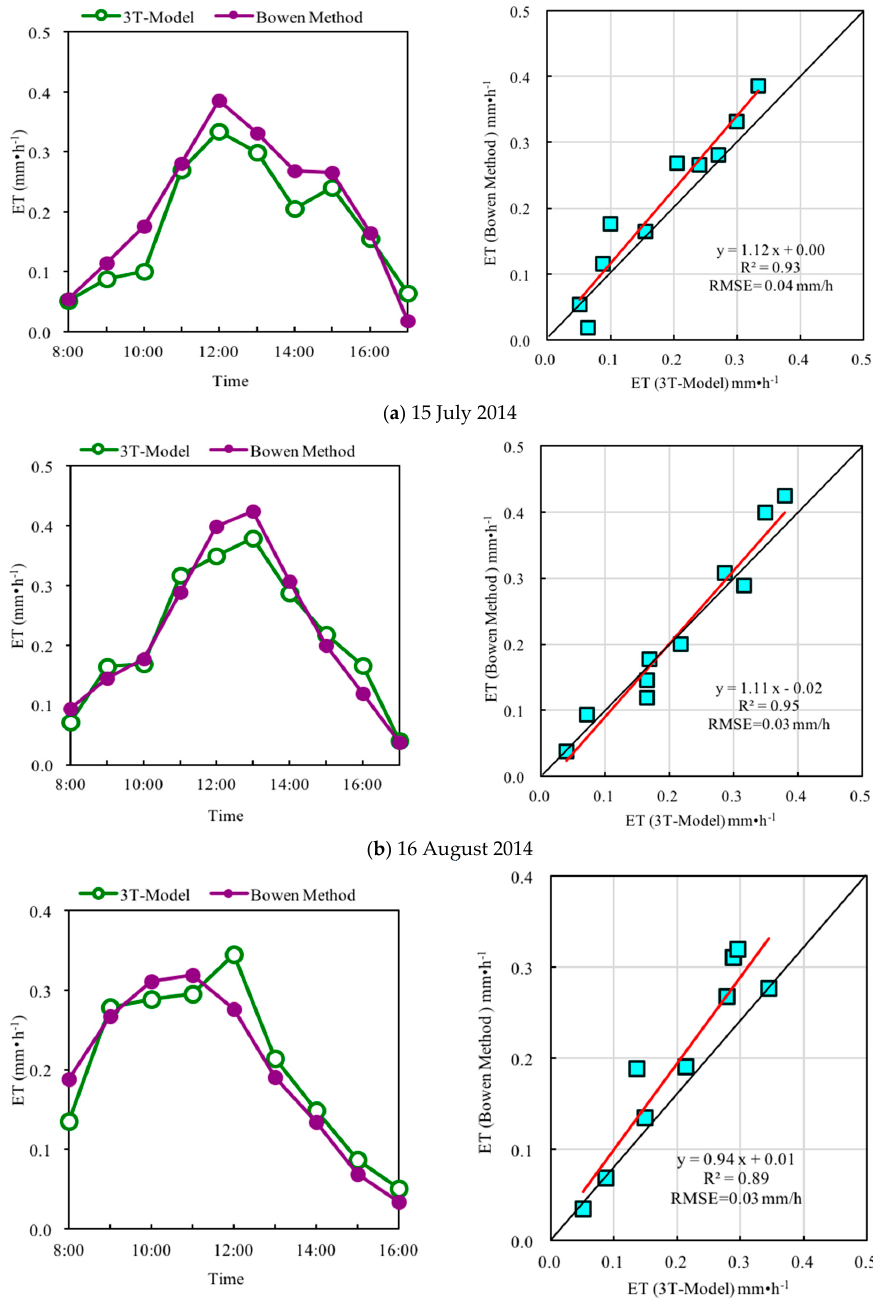
Figure 7. ( a – c ) Comparison of the lawn ET estimated using the ‘infrared RS + 3T model’ and Bowen ratio method.